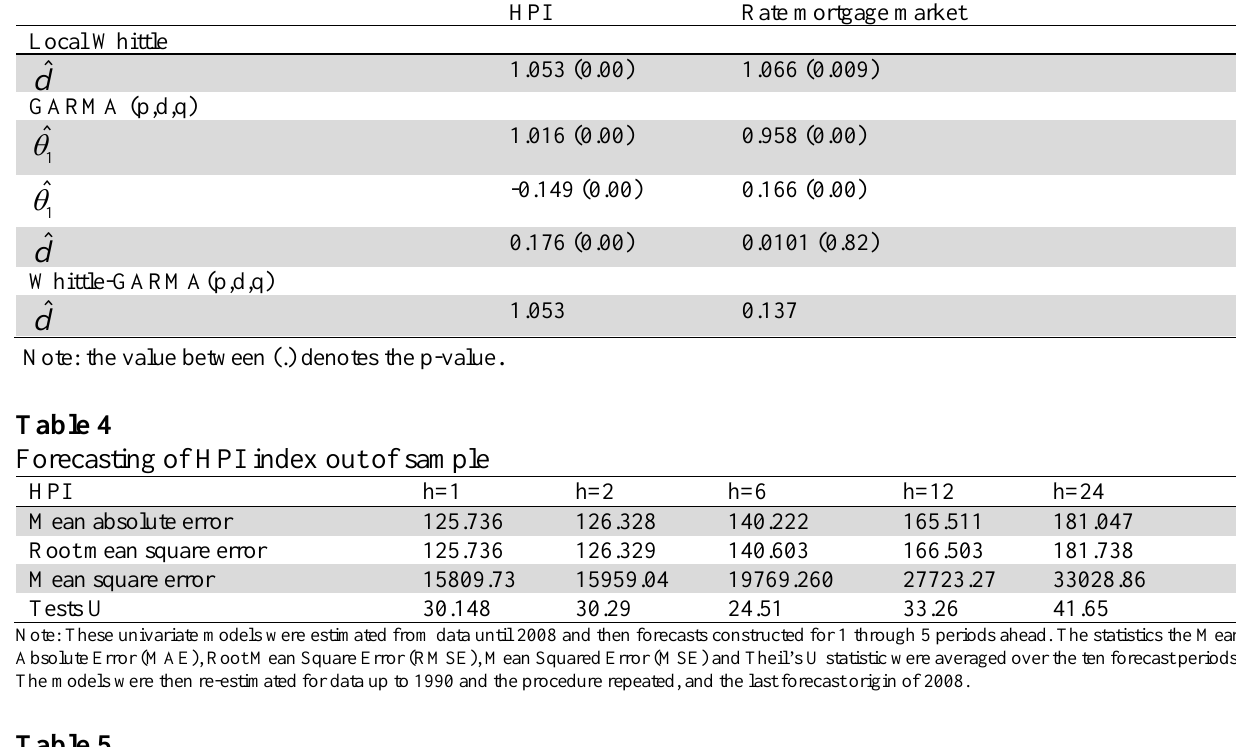
Forecasting of Mortgage Market Rate index out of sample Rate Mortgage h=1 h=2 Mean absolute error 1.64 Mean square